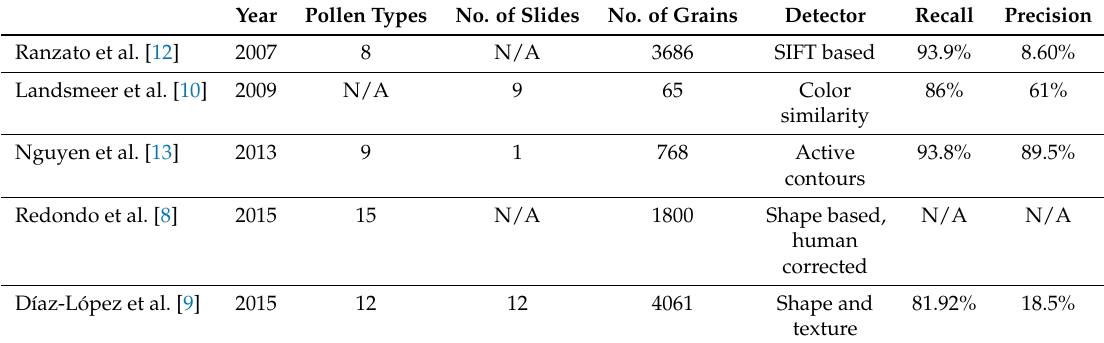
Table 1. Overview of recently-published results about automatic pollen grain